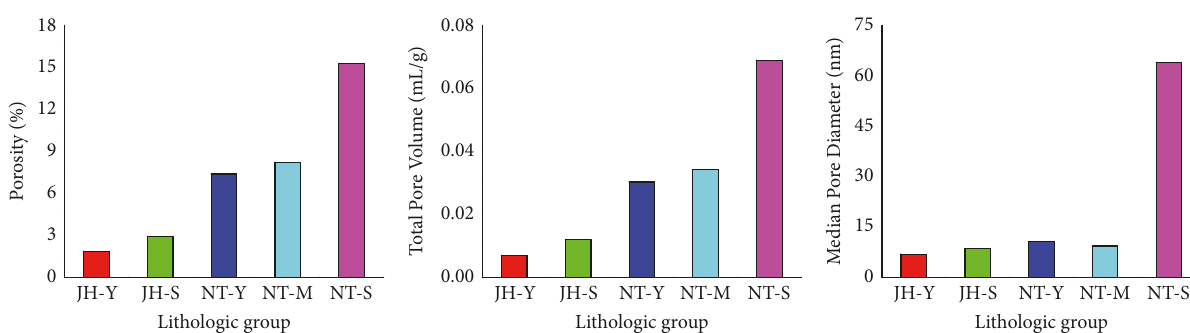
= 11.62%; 𝐾 𝑔 = 0.0028 mD). Avg